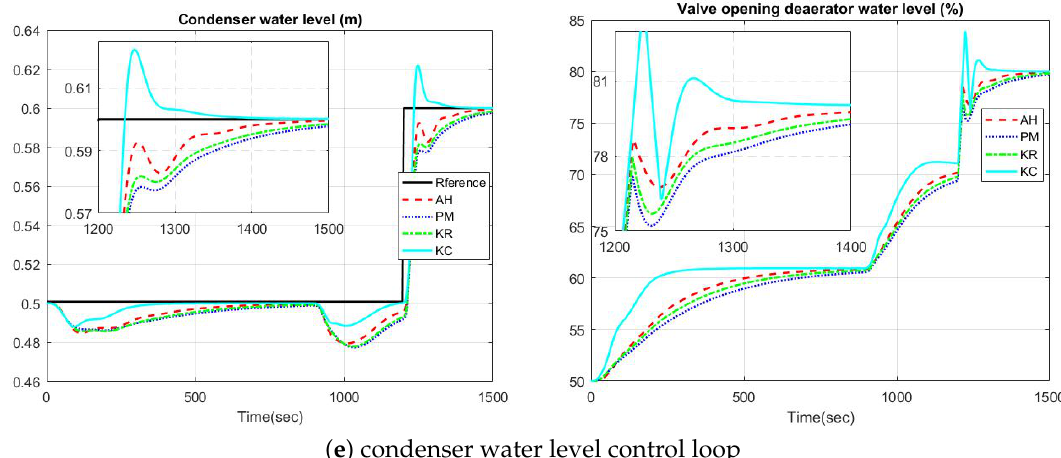
Figure 8. Outputs of the steam/water loop with different PID autotuning methods (The outputs are listed on the left and the inputs are listed on the right).